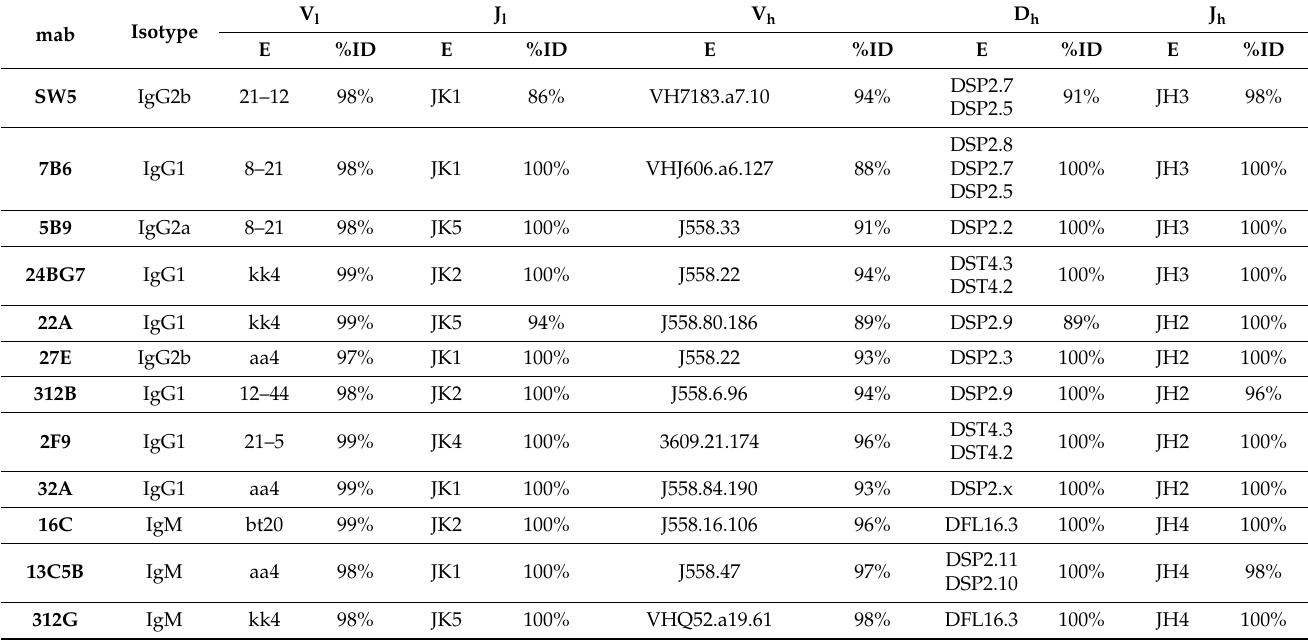
Figure 1. Development of monoclonal antibodies (mabs). ( A ) Conventional hybridoma technology starts with repeated immunizations of mice with the antigen. Isolated spleen cells are fused with myeloma cells resulting in hybridomas. Cell culture supernatants of the hybridomas are screened for the presence of the requested mab. Cells secreting the ab of interest are subcloned to a single cell level; ( B ) As in ( A ), we also started with immunization of (non-transgenic) mice. However, T cells were isolated from spleens of the immunized animals and adoptively transferred into human La transgenic animals, as described previously [50]. The serum of the mouse was tested for anti-La mabs. After seroconversion, the spleen was isolated and the hybridoma fusion was performed, as schematically summarized in ( A ). Table 1. Summary of identified VJ and VDJ elements. Estimated DNA sequences of the variable domains were compared with the NCBI data library using IgBlast sequence analysis tool. The name of the best fitting V, D, and J element (E) of the light (l) or heavy (h) chain is listed which was used for calculation of the mutation rate. %ID, percentage of identity. The estimated Ig isotype is also